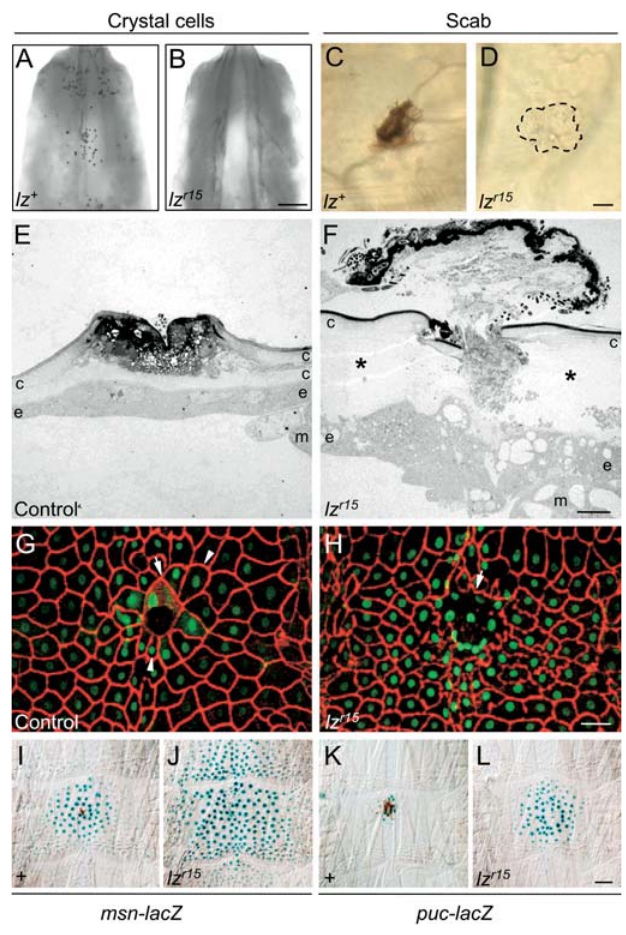
Figure 6. Effect of lz on Scab Formation and the Other Events of Puncture Wound Healing (A and B) Posterior of lz þ ( w 1118 ) (A) and lz r15 mutant (B) L3 larvae. Larvae were heated so crystal cells appear as tiny black dots. No crystal cells are apparent in the lz r15 mutant. Bar, 200 l m. (C and D) Micrographs of control lz þ ( w 1118 ) (C) and lz r15 mutant (D) L3 larvae 4 h after puncture wounding. No scab is seen at the lz r15 wound site (encircled). Bar, 50 l m. (E and F) TEM sections through 24-h–old puncture wounds of a control lz r15 / þ heterozygote (E) and a hemizygous lz r15 mutant larva (F), both carrying the msn-lacZ transgene. A consolidated, electron- dense scab has formed in the control larva (E), but only a diffuse plug with peripheral electron density is present at the lz r15 hemizygous wound (F). The electron density of the lz r15 plug might be due to residual melanization activity in the lz r15 mutant. Although reepithe- lialization is complete in the lz r15 mutant wound, the epidermis contains large vacuoles and abundant apical processes, and it is separated by a gap (asterisks) from the old cuticle and has not secreted new cuticle. Other 24-h lz r15 mutant wounds analyzed had necrotic or discontinuous epidermis at the wound site (not shown). Bar, 10 l m. (G and H) Fluorescence micrographs of 20-h puncture wounds in control (G) and lz r15 mutant (H) larvae carrying the msn-lacZ reporter that were treated as above and immunostained for Fasciclin III (red) and b -galactosidase (green). Epidermal cells at both control and lz r15 mutant wounds have fused to form syncytia (arrows), and cells in the control are oriented toward the wound site (arrowheads). The orientation response of epidermal cells in the lz r15 mutant is difficult to assess because cell borders out to six cell diameters away from the wound appear slack and wavy. Bar, 50 l m. (I–L) X-gal stains of 6-h–old puncture wounds of control lz þ (I and K) or lz r15 hemizygous mutant larvae (J and L) carrying either msn-lacZ (I and J) or puc-lacZ (K and L). Note the absence of scabs and the increase in reporter activity (blue) in lz r15 . The basal level of